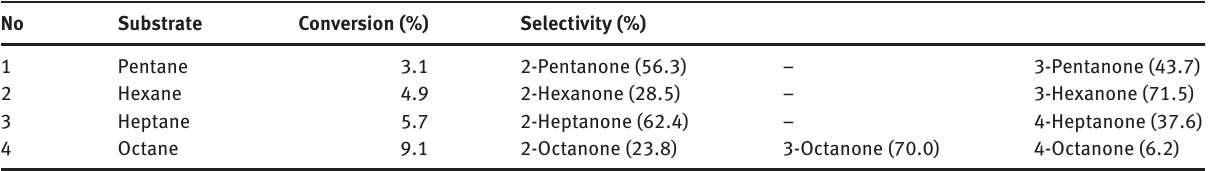
Table 3: Oxidation of linear alkanes catalyzed by CF-MNPs 6